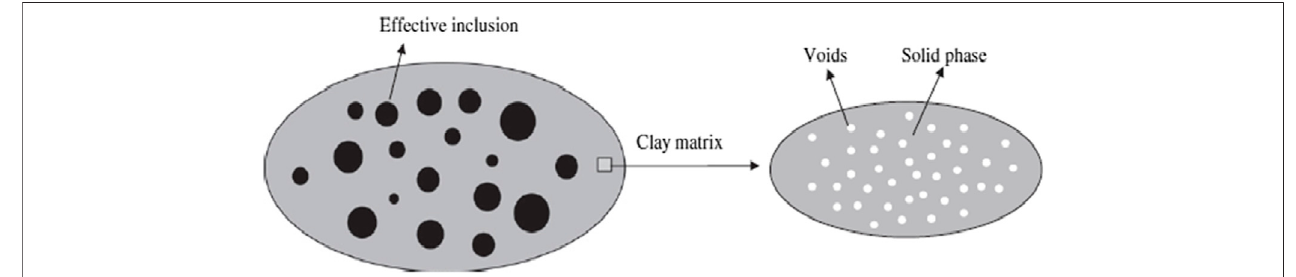
FIGURE 4 | Basic principle program of the two-step homogenization method (Shen et al., 2012).